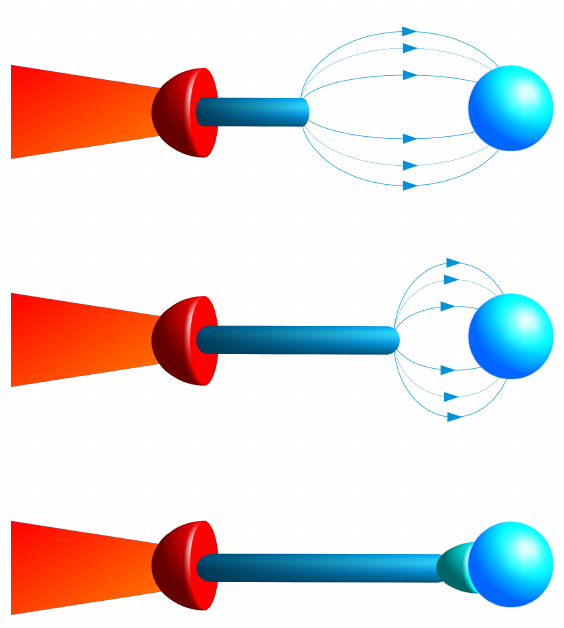
Figure 1. Cut in the plane of the star perpendicular to the left side of an edge-on accreting disk where the dust (red) destruction radius is further from the star than the gas disk (blue). Three possible scenarios are shown corresponding to decreasing strengths of the stellar magnetic field from top to bottom. Gas is channeled through the field lines according to MA (top and middle panels, corresponding to decreasing sizes of the magnetosphere), and directly onto the star through a BL (indicated in cyan at the bottom panel) in the absence of a strong enough magnetic